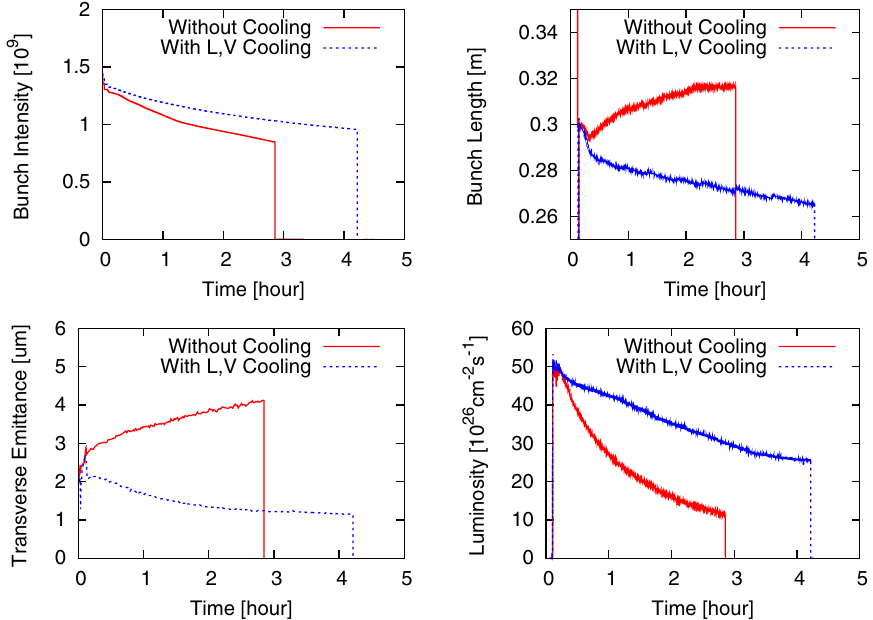
FIG. 1. Comparison of two fills in 2011 100 GeV Au-Au run, one without cooling and one with longitudinal and vertical cooling. Top-left: bunch intensities. Top-right: rms bunch lengths of central bunch. Bottom-left: transverse emittances. Bottom-right: luminosities at IP8 from Zero Degree Calorimeters (ZDCs). This comparison was made with